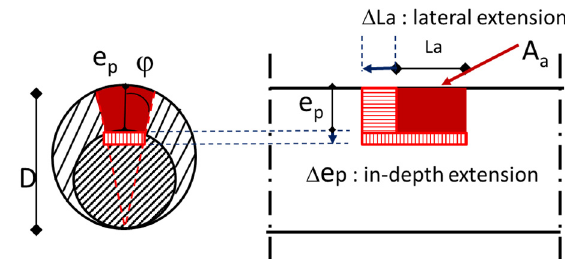
Figure 15. Localized corrosion of reinforcement rebar : in ‐ depth and lateral extension of anodic site. At a given time t prop , the area of the anodic zone is given in